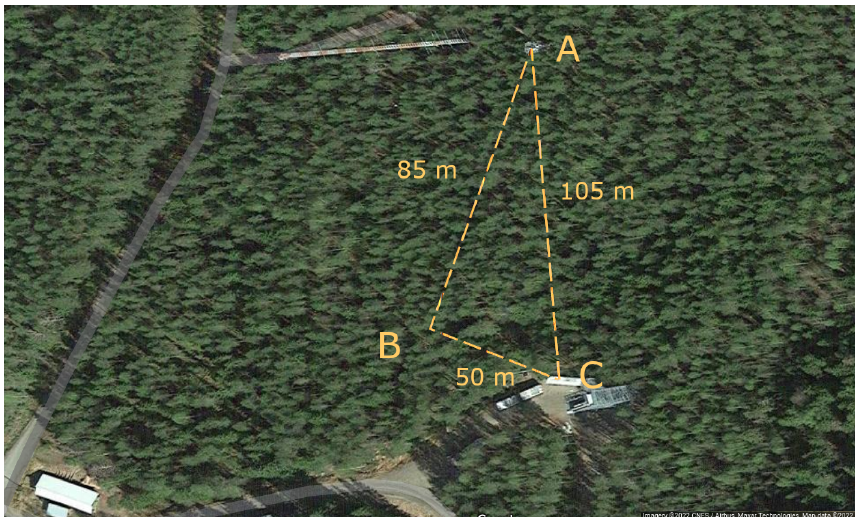
Figure 1. The locations of the ion size distribution measurement at site A (BSMA) and the radiation measurements at site C (at site B prior to 2019) and their distances from one another (© Google Maps 2022).